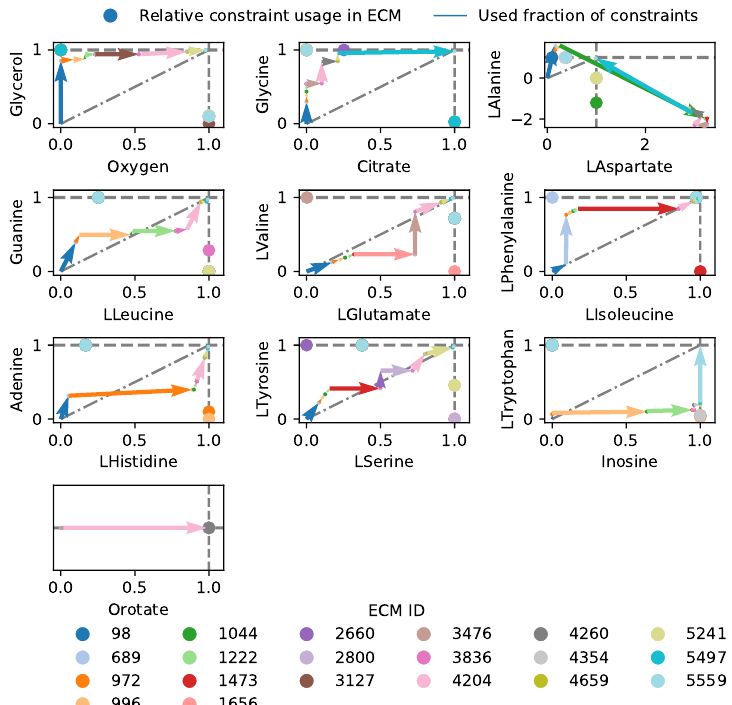
Figure A3. The costs of all the used EMs for the different constraints in Lactobacillus plantarum . The pairing of the constraints in the plots is based on their scaled reduced costs, which quantifies how strongly the constraint limits the production of biomass. Oxygen-limitation forms the strongest constraint, followed by glycerol, citrate,